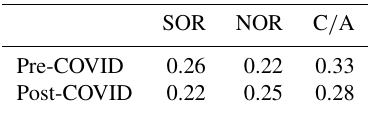
Table 1. SOR, NOR, and C / A values in pre-COVID and post- COVID (SOR = SO 2 −